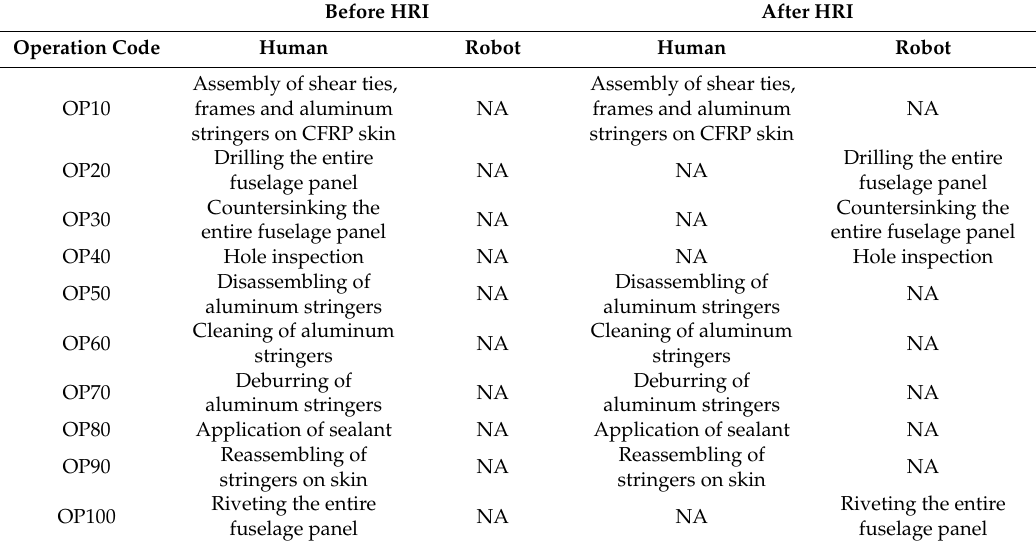
Table 2. General aircraft panel assembling operations before and after HRI. Before HRI After